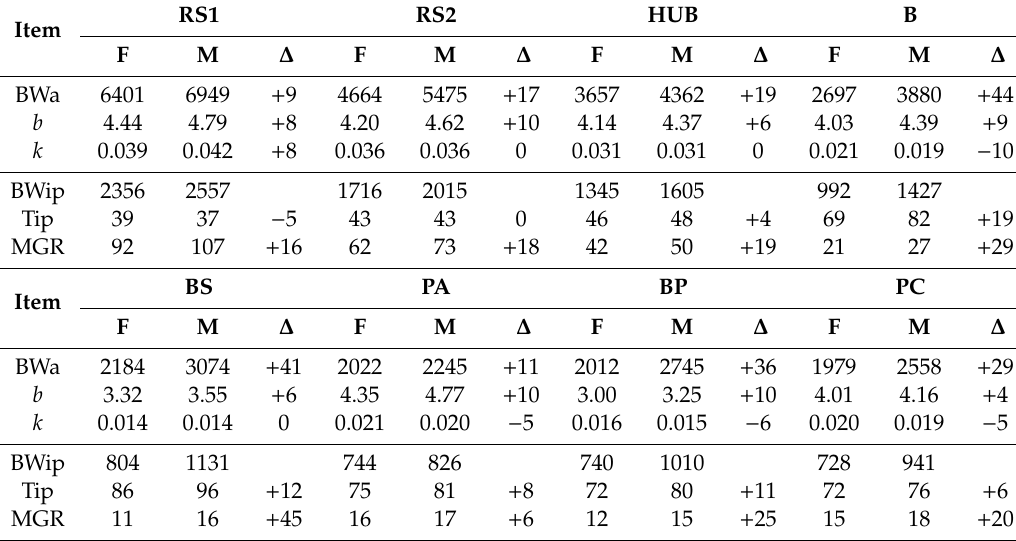
Table 4. Growth curve parameters according to the Gompertz model (G1) for the Bianca di Saluzzo and Bionda Piemontese chicken breeds: comparison with other breeds / hybrids. Data obtained from